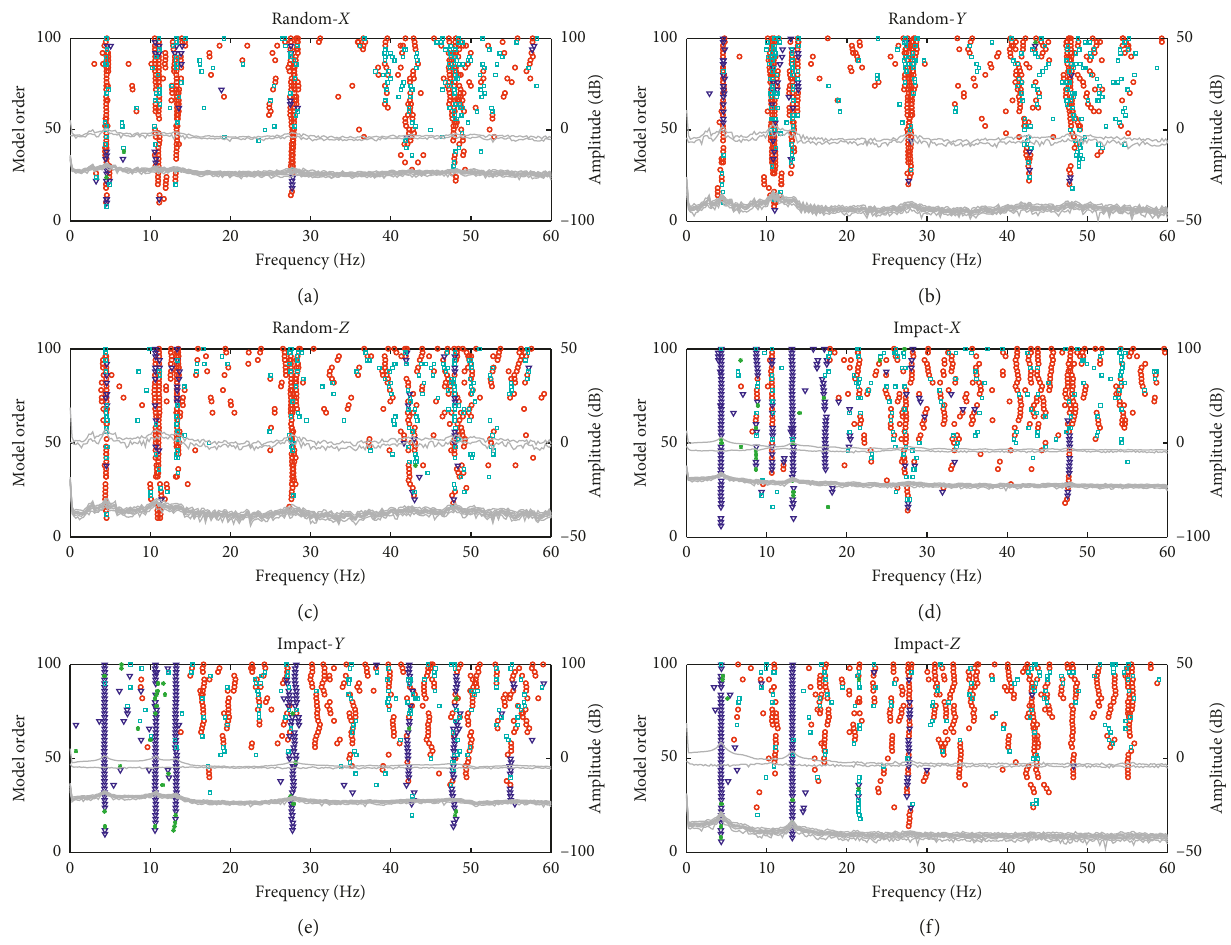
Figure 9: Stabilization diagram based on SSI-Data: X , Y , and Z directions under (a–c) random excitation and (d–f) impact excitation.